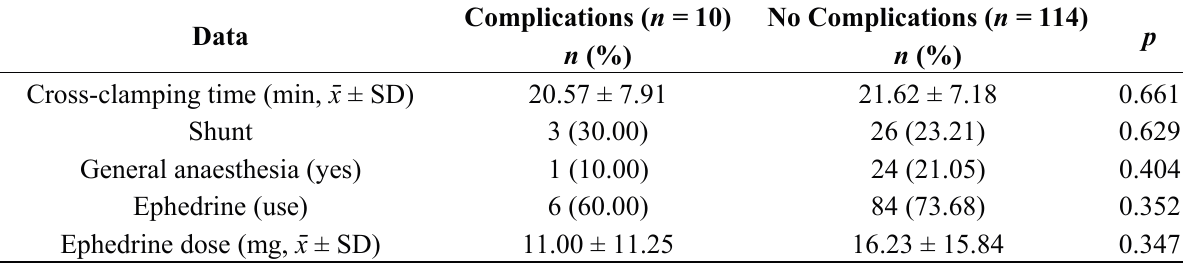
Table 2. Intraoperative data for carotid endarterectomy procedures in groups with and without 30-day complications.